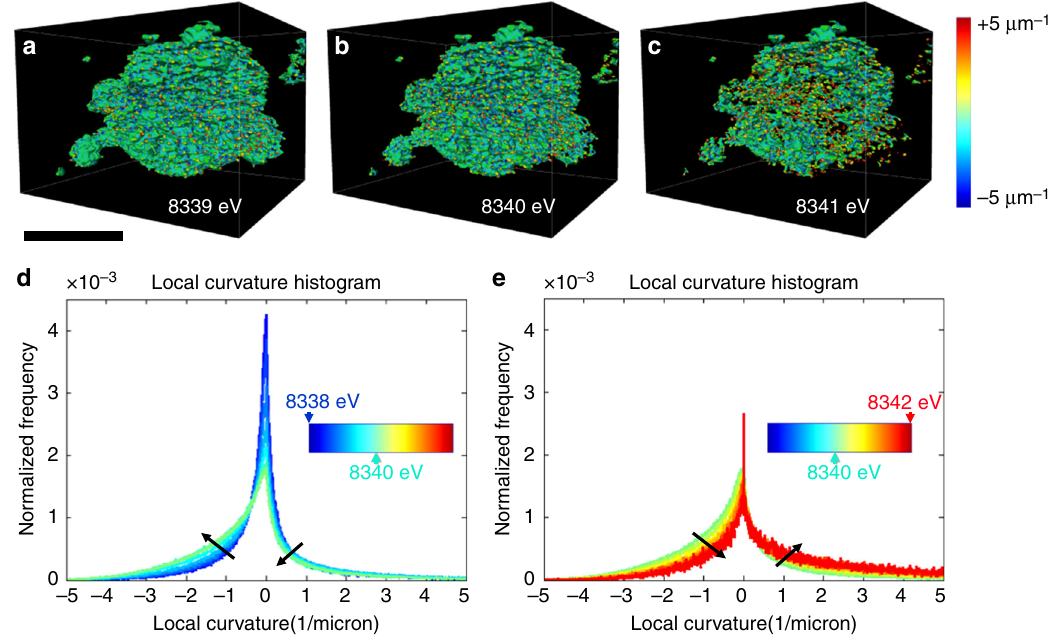
Fig. 4 Evolution of local valence curvatures upon the phase transformation. Isosurfaces of the 3D Ni valence state maps at a 8339 eV, b 8340 eV, and c 8341 eV. The surface is color coded to the local valence curvature, with red and blue denoting the extremes of positive and negative curvature, respectively. d , e The histograms for the changes of local valence curvatures as a function of the selected energy value d from 8338 to 8340 eV and e from 8340 to 8342 eV are shown. The scale bar is 10 μ m